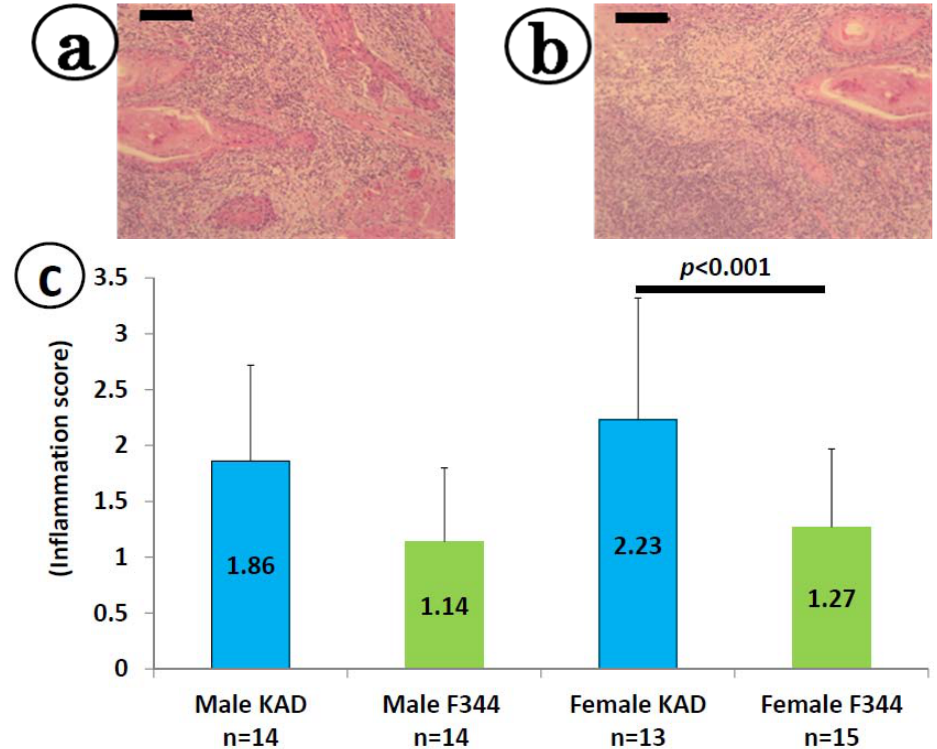
Figure 3. Inflammation scores for the tongue in the KAD and F344/NS1c rats. ( a ) and ( b ) are representative photos of tongue SCCs with inflammation in a male KAD and female KAD rat, respectively. ( c ) The values of the inflammation score represent the mean ±